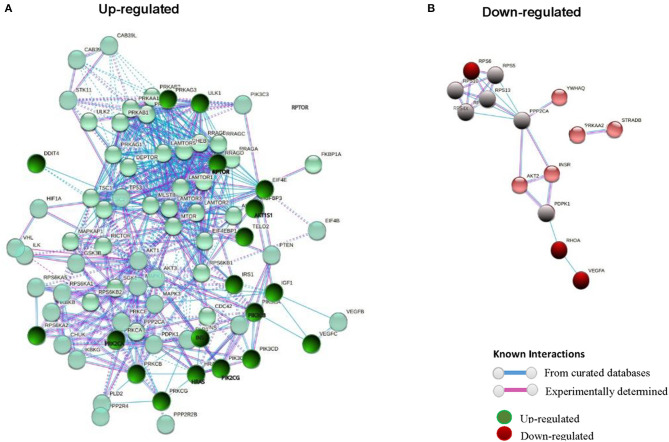
STRING interaction pathway of differentially expressed mTOR pathway genes comparing +AMR/+DSA and +DSA vs. –AMR/–DSA KT patients. (A) Green nodes indicate up-regulated genes. (B) Red nodes indicate down-regulated genes. The intensity of the color indicates the degree of regulation of the gene. The blue line shows that the interaction is checked against from curated databases and the purple line shows that the interaction is experimentally determined.